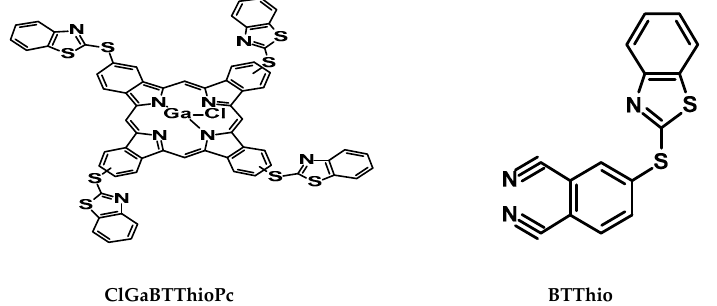
Figure 1. Structures of 4-(benzo[d]thiazol-2-ylthio)phthalonitrile (BTThio) and tetrakis[(benzo[d]thiazol-2-ylthio)phthalocyaninato] gallium(III) chloride (ClGaBTThioPc).